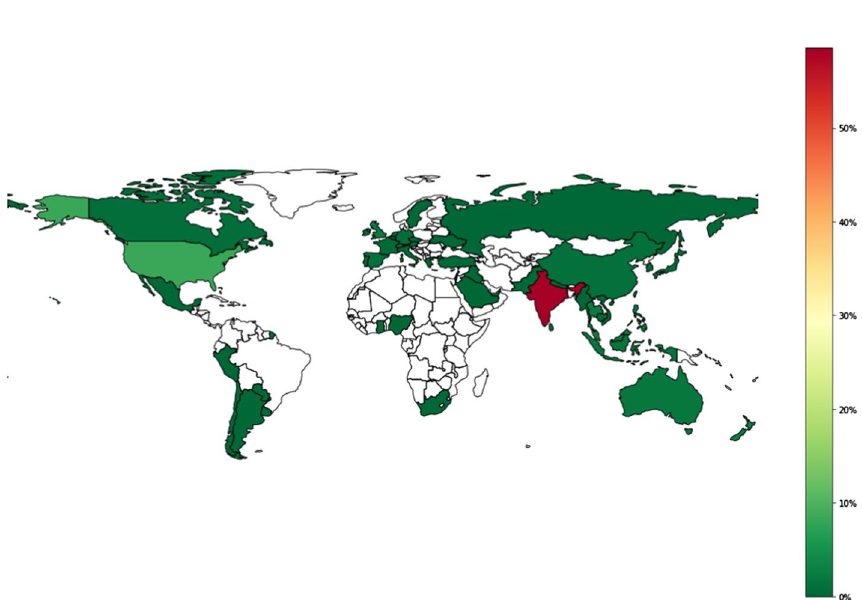
Fig. 2 Distribution of Twitter users for #RCEP